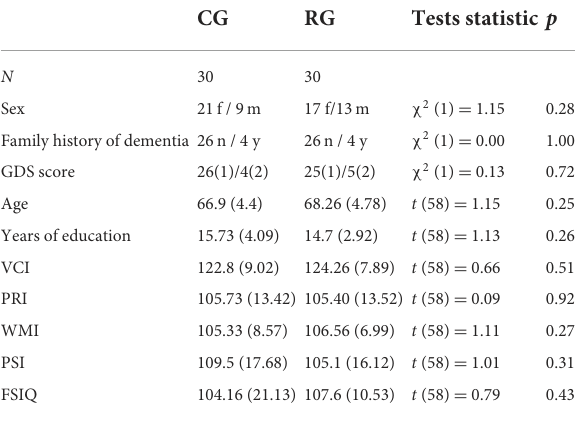
TABLE 1 Demographic and psychometric assessments of intelligence of the control group (CG) and the risk group (RG) according to the